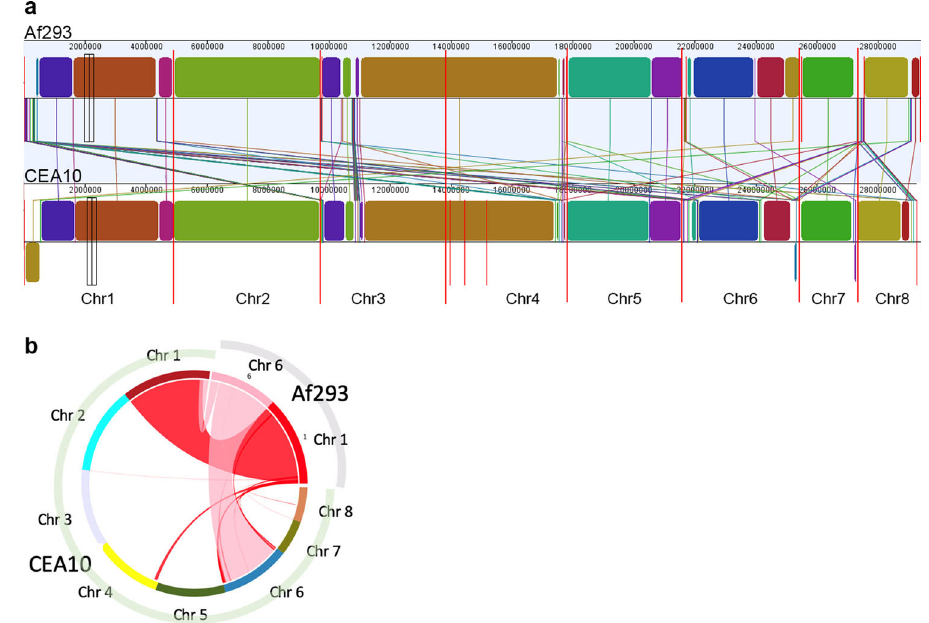
Fig. 5 | Chromosomal rearrangements observed between Af293 and CEA10. a Mauve plot of synteny 24 between Af293 and CEA10. Chromosomes are marked along the bottom of the panel. Syntenic blocks are shown as different coloured boxes for both strains with identical colours indicating synteny. Connecting lines are shown to indicate chromosome rearrangement. Note that the threshold for